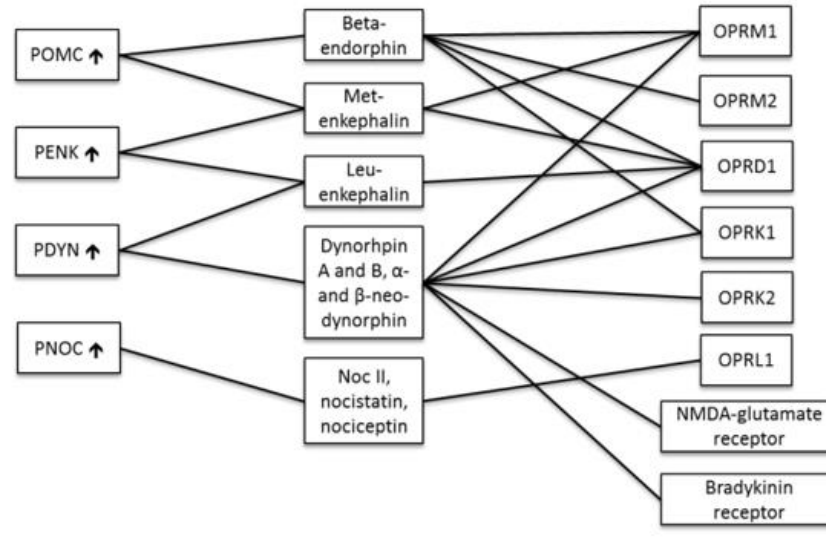
Figure 1. Main known regulatory links between the genes of the melanocortin system and enzymes of melanogenesis. ↑ — up-regulation of mRNA in lesional psoriasis skin. ↓ — down-regulation of mRNA in lesional psoriasis skin. In the case of POMC, MC2-4R, ASIP, TYR and TYRP1, the results are from our previous study [16]. The components of the melanocortin system are indicated with light gray and the associated factors that were investigated in this study are indicated with dark gray. Double borders indicate melanogenesis enzymes.